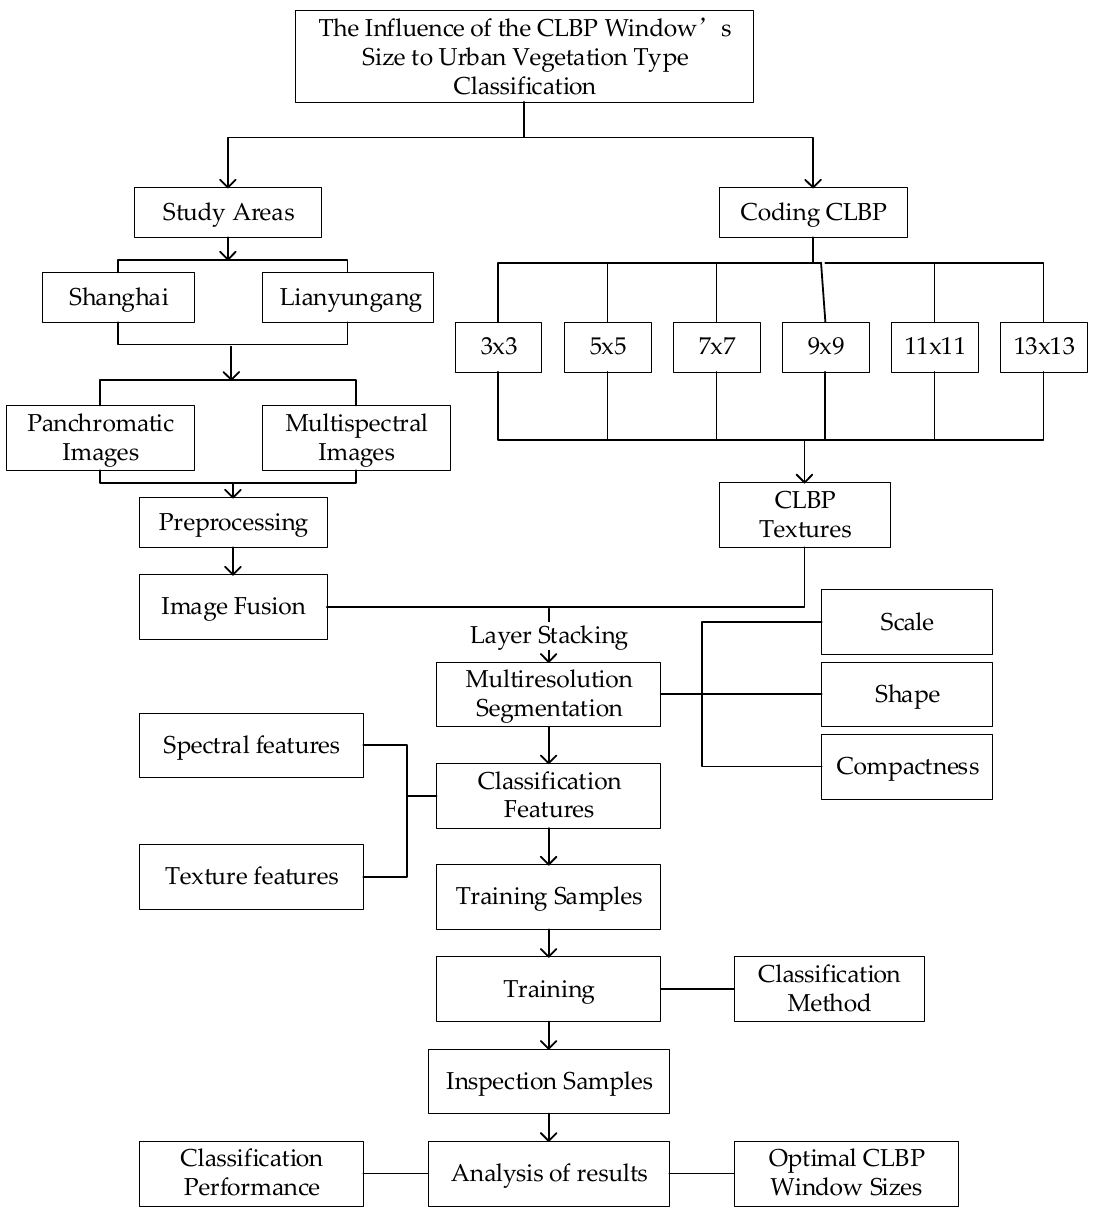
Figure 1. The experimental process.